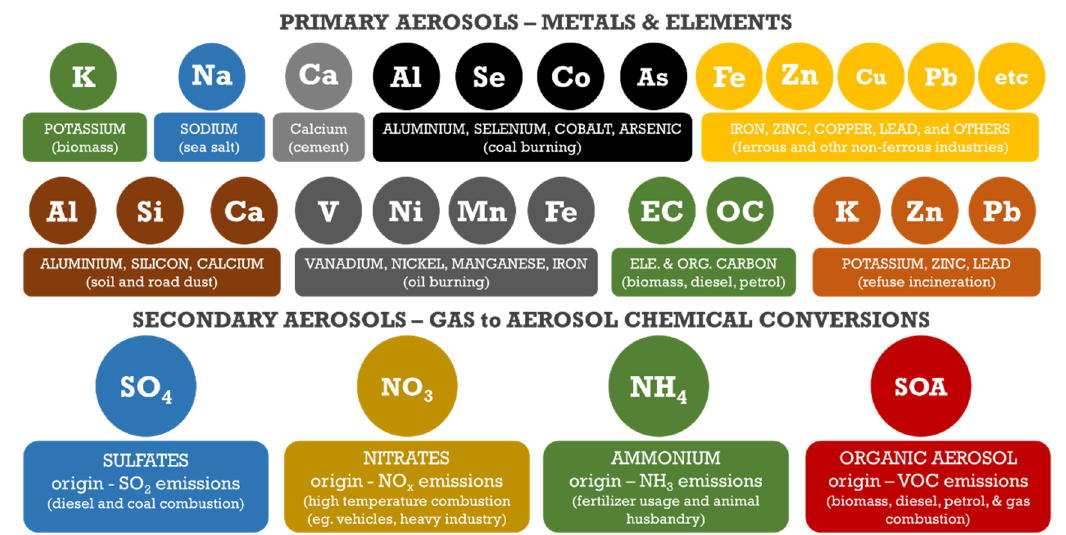
Figure 4. Key metal and ion markers of various sources contributing to PM 2.5.